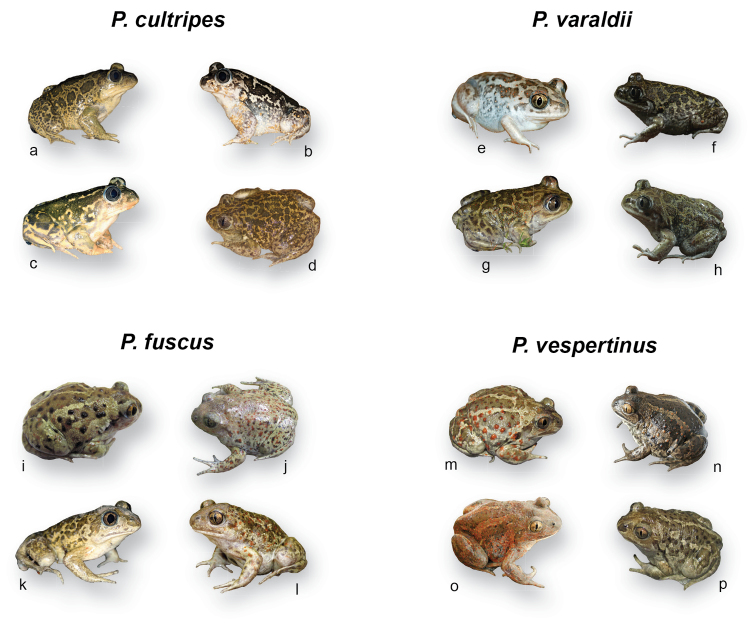
Color variation in Pelobatescultripes, P.varaldii, P.fuscus and P.vespertinus. Photo credits and origins as follows a CD (Hérault, France) b, c CD (Algarve, Portugal) d A Sanchez Vialas (Spain) e G Martinez (Kenitra, Morocco) f–h A Sanchez Vialas (Tanger, Morocco) i, j N Suriadna (Ukraine) k CD (Wojewodztwo podkarpackie, Poland) l A Nöllert (Burgenland, Austria) m–p N Suriadna (Ukraine).